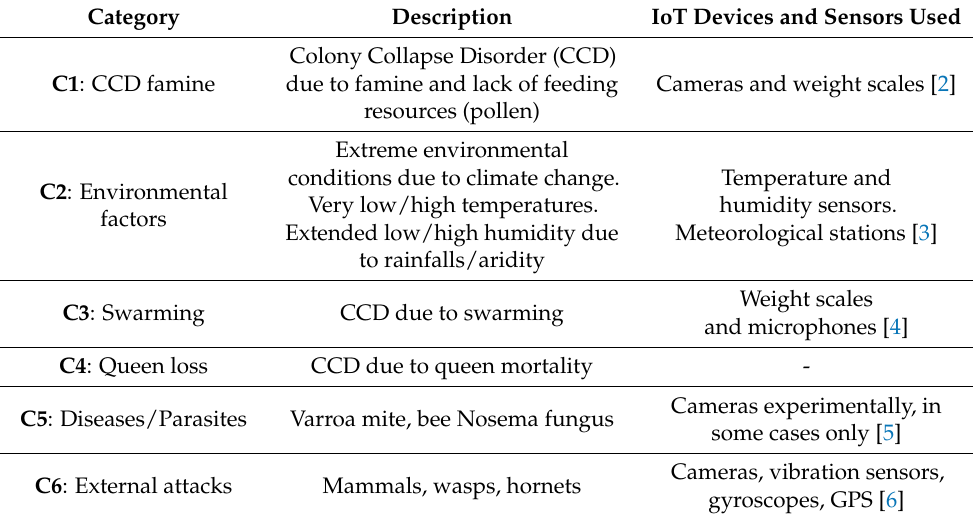
Table 1. Beehive condition incident classification and current sensory technologies used by IoT devices [2–6].